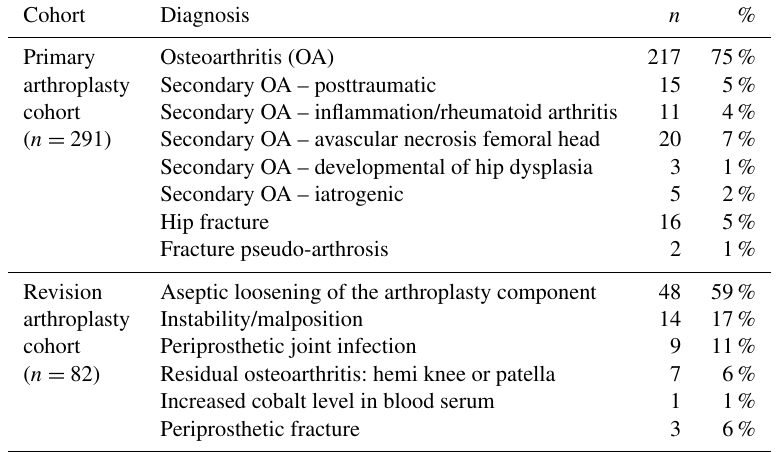
Table 2. Indication of primary and revision